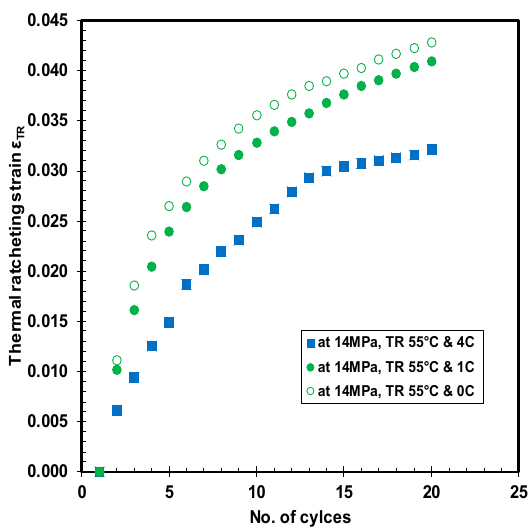
Figure 10. Thermal ratcheting strain under different time periods of initial creep at 14 MPa.